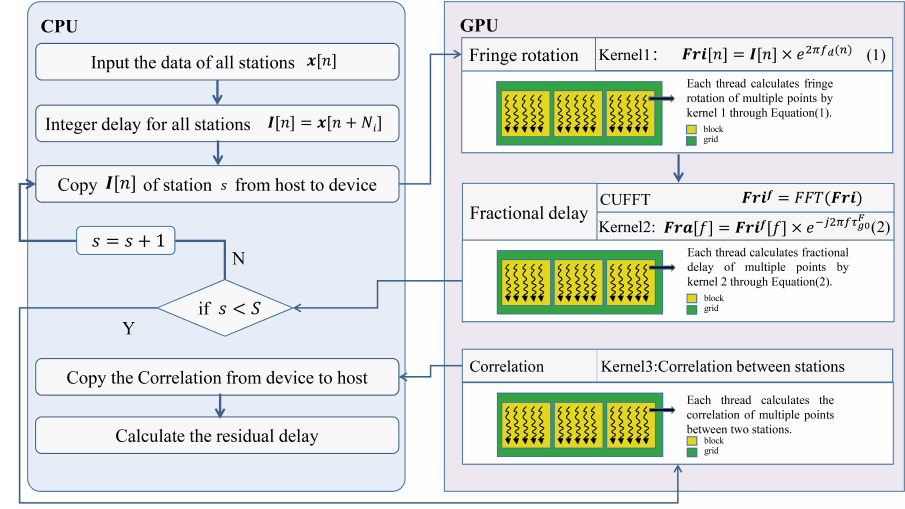
Figure 5. GPU-based parallel VLBI